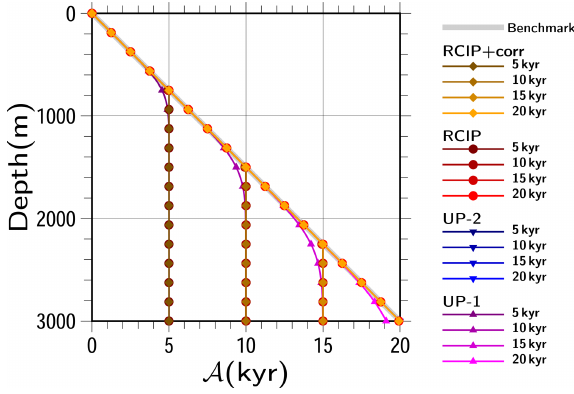
Figure 2. Experimental results obtained using a uniform velocity of w = 15cmyr − 1 . Snapshots of the computed vertical age profiles obtained by RCIP with correction, RCIP, second-, and first-order upwind schemes at t = 5, 10, 15, 20kyr are shown. Since the “cor- rection factor” of the departure points is 1 (Eq. 28), the results of RCIP with correction are identical to those of RCIP. The results of the second-order upwind scheme are close to those of the RCIP, which are barely visible at this scale. The solution is also shown as a benchmark (thick gray line). Symbols are plotted for every eight vertical